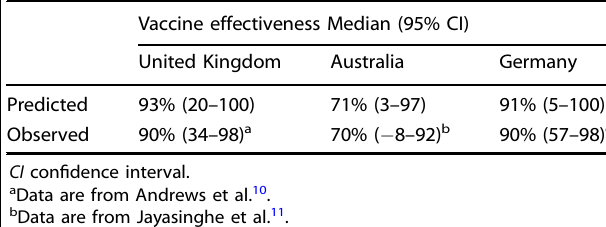
Table 3. Predicted versus observed aggregate vaccine effectiveness for the PCV7 serotypes in